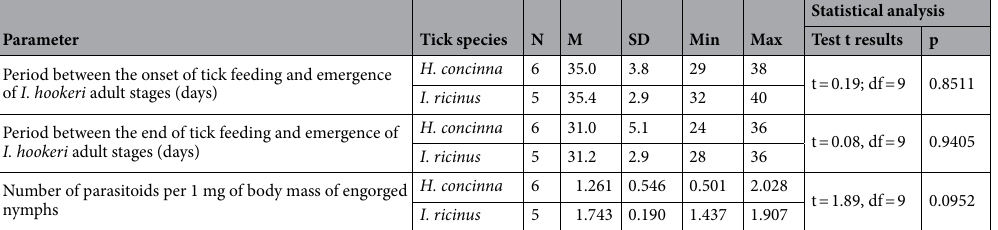
Period between the onset of tick feeding and emergence of I. hookeri adult stages (days) Period between the end of tick feeding and emergence of I. hookeri adult stages (days) Number of parasitoids per 1 mg of body mass of engorged Table 3. Development of endoparasitoid Ixodiphagus hookeri wasps in Haemaphysalis concinna and Ixodes ricinus nymphs collected in the Slovak Karst, Slovakia. N number of nymphs involved in the study, M mean, SD standard deviation, Min minimum, Max maximum.